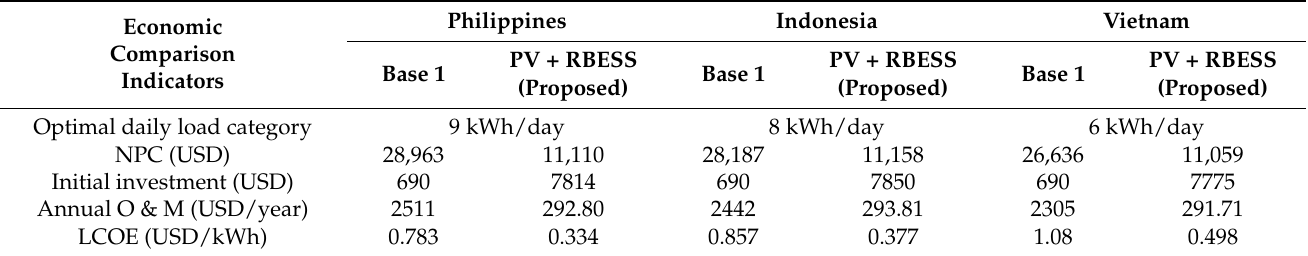
Table 13. LCOE comparison with diesel consumption at optimal average daily